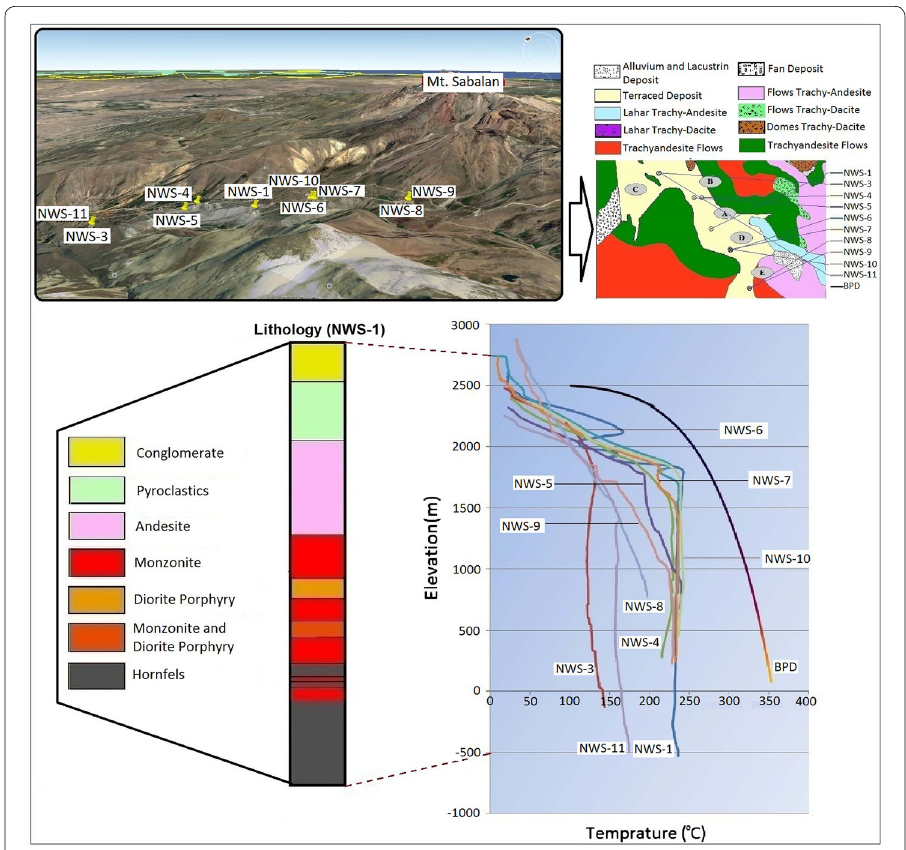
Fig. 9 Stable well temperatures for the NW Sabalan